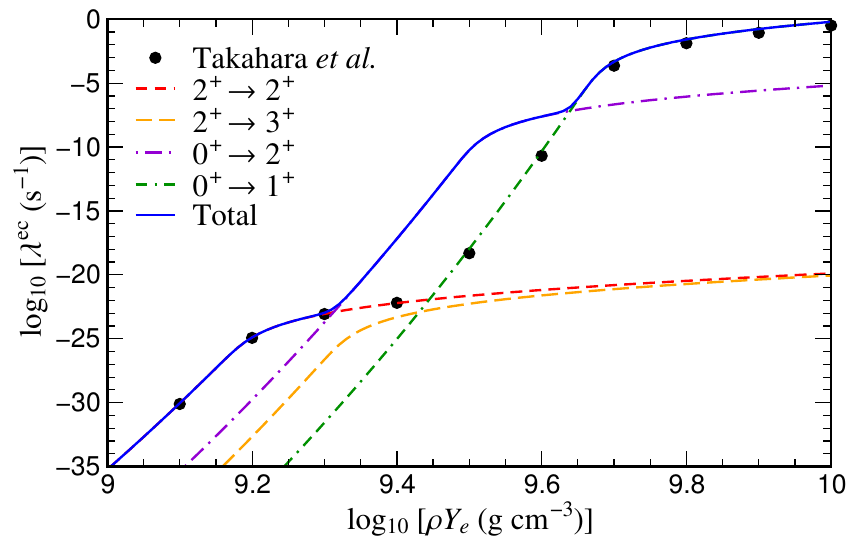
Figure 2. Electron capture (ec) rate for 20 Ne as function of density and for a specific temperature (log T [ K ] = 8.6) relevant for the core evolution of intermediate-mass stars. The rate is broken down to the individual state-by-state contributions. In the density regime, particularly relevant for core evolution, the rate is dominated by the second-forbidden ground-state-to-ground-state transition. The rates labeled ’Takahara et al.’ are derived from allowed transitions calculated in the shell model [44]. Taken from